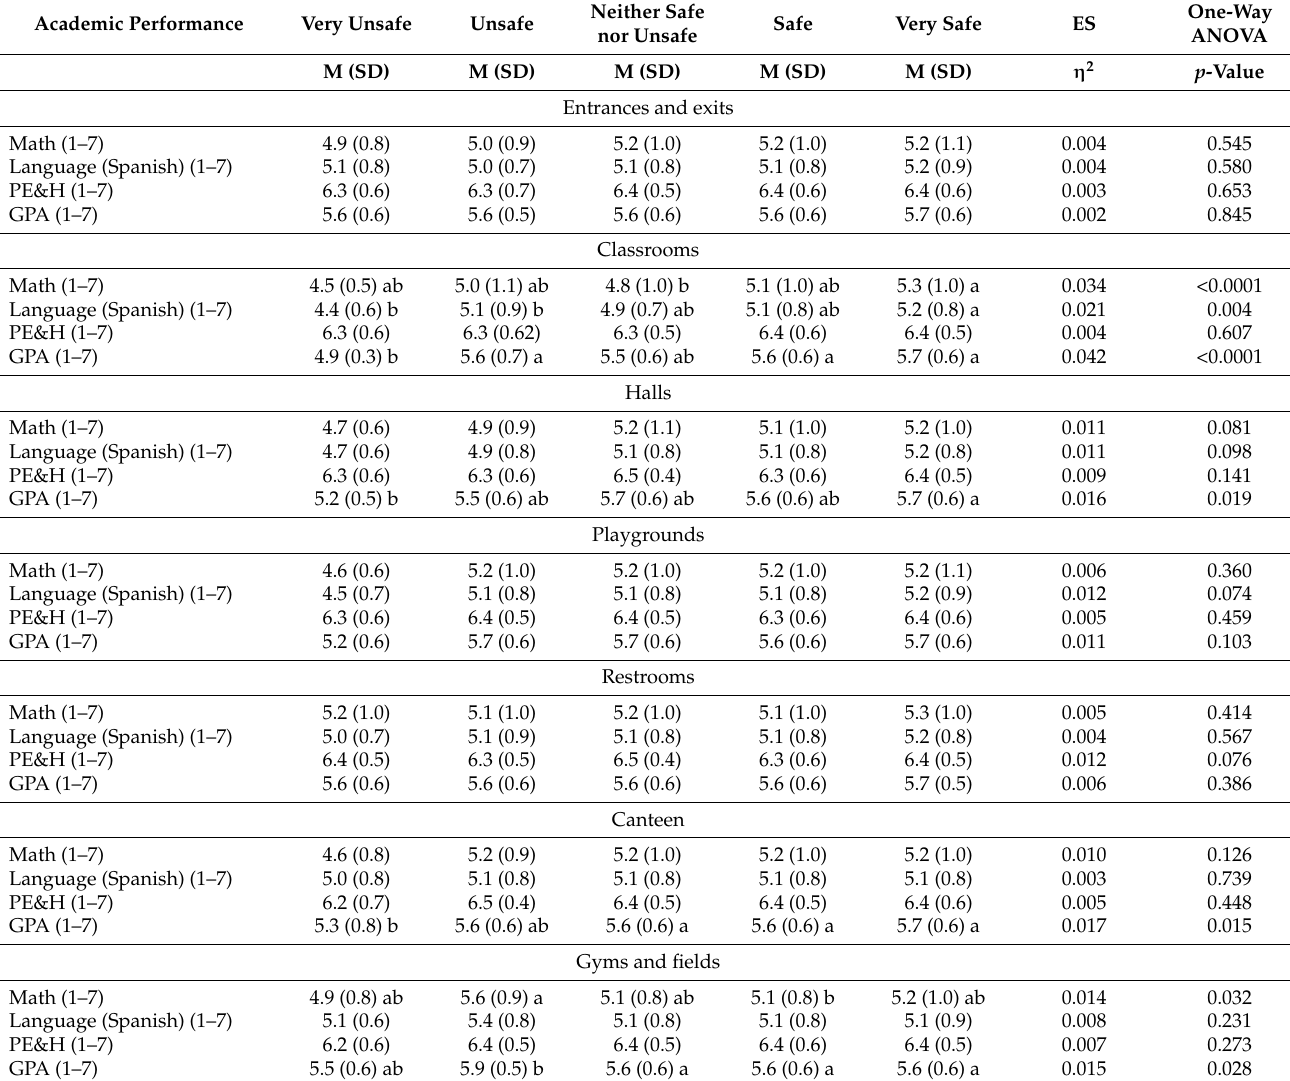
Table 5. Accumulated final grades and GPAs according to the perception of the levels of safety and unsafety in different school